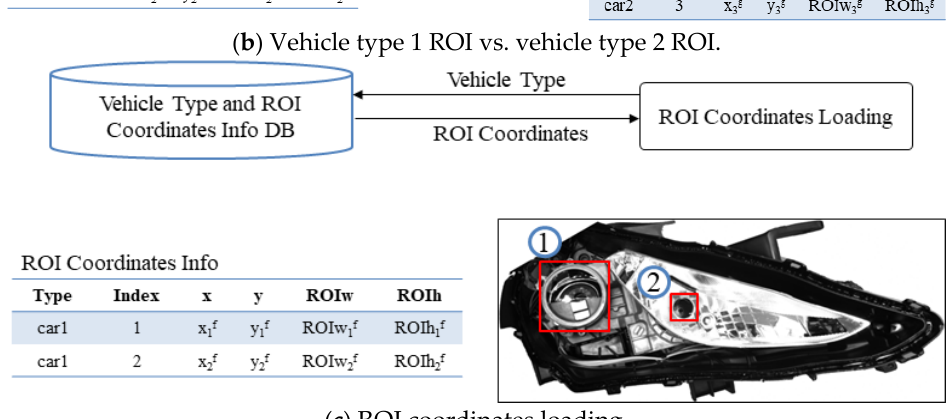
Figure 9. ROI coordinates setting and loading.